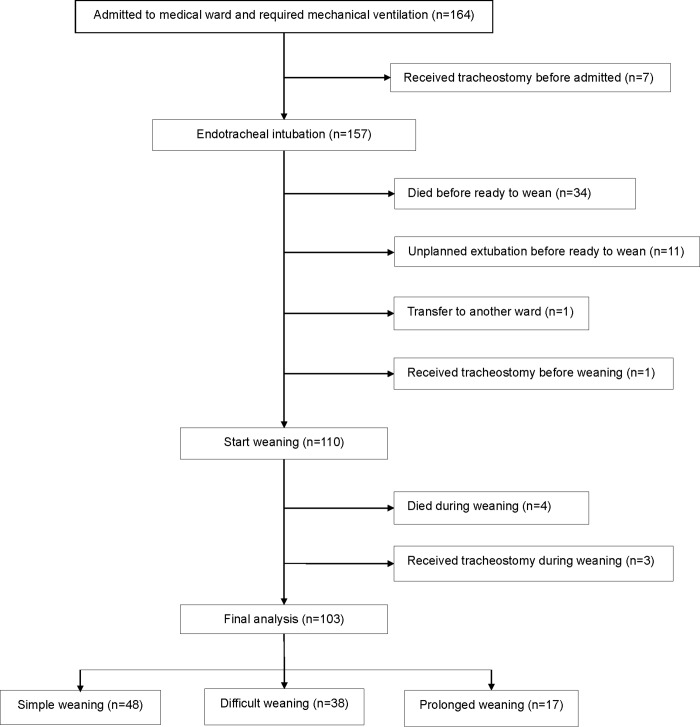
Study flowchart indicates inclusion and exclusion population.